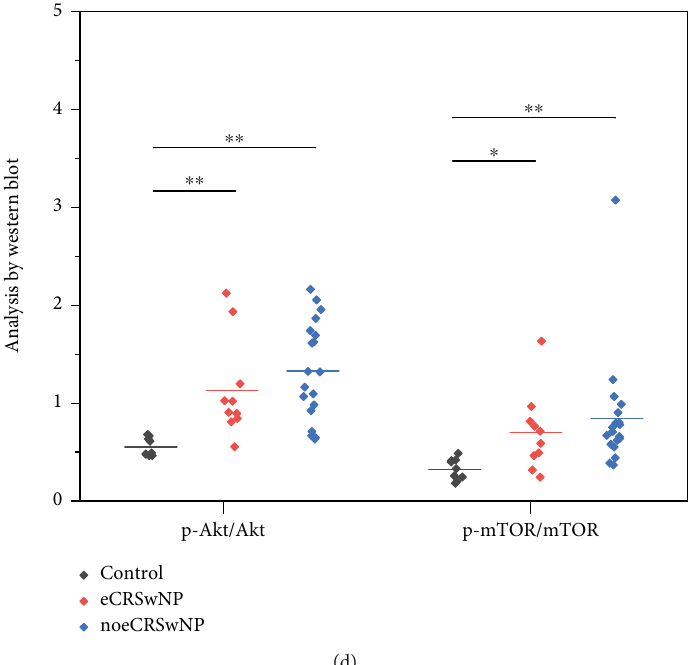
Figure 2: Activation of the Akt/mTOR pathway in di ff erent CRSwNP subtypes. (a, b) The IHC analysis showed that the expression levels of p-Akt and p-mTOR in the nasal tissues of patients with eCRSwNP or noeCRSwNP were not signi fi cantly di ff erent from those observed in control tissues. (c, d) The western blot analysis showed that the expression of p-Akt/Akt and p-mTOR/mTOR was signi fi cantly greater in patients with eCRSwNP or noeCRSwNP than in control tissues. ∗ P < 0 : 05 , ∗∗ P < 0 : 001